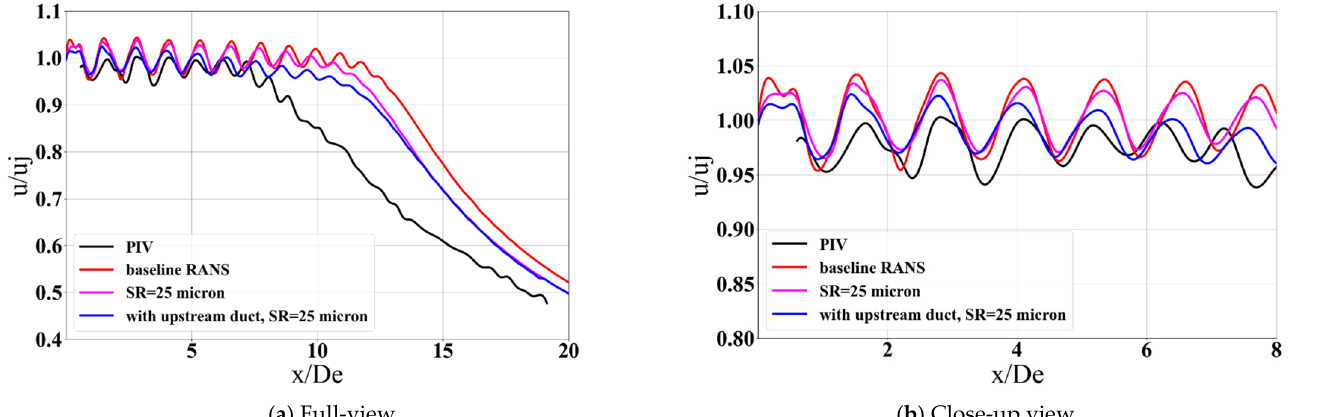
Figure 12. Effect of nozzle wall surface roughness on jet centerline velocity compared with PIV data from [60].